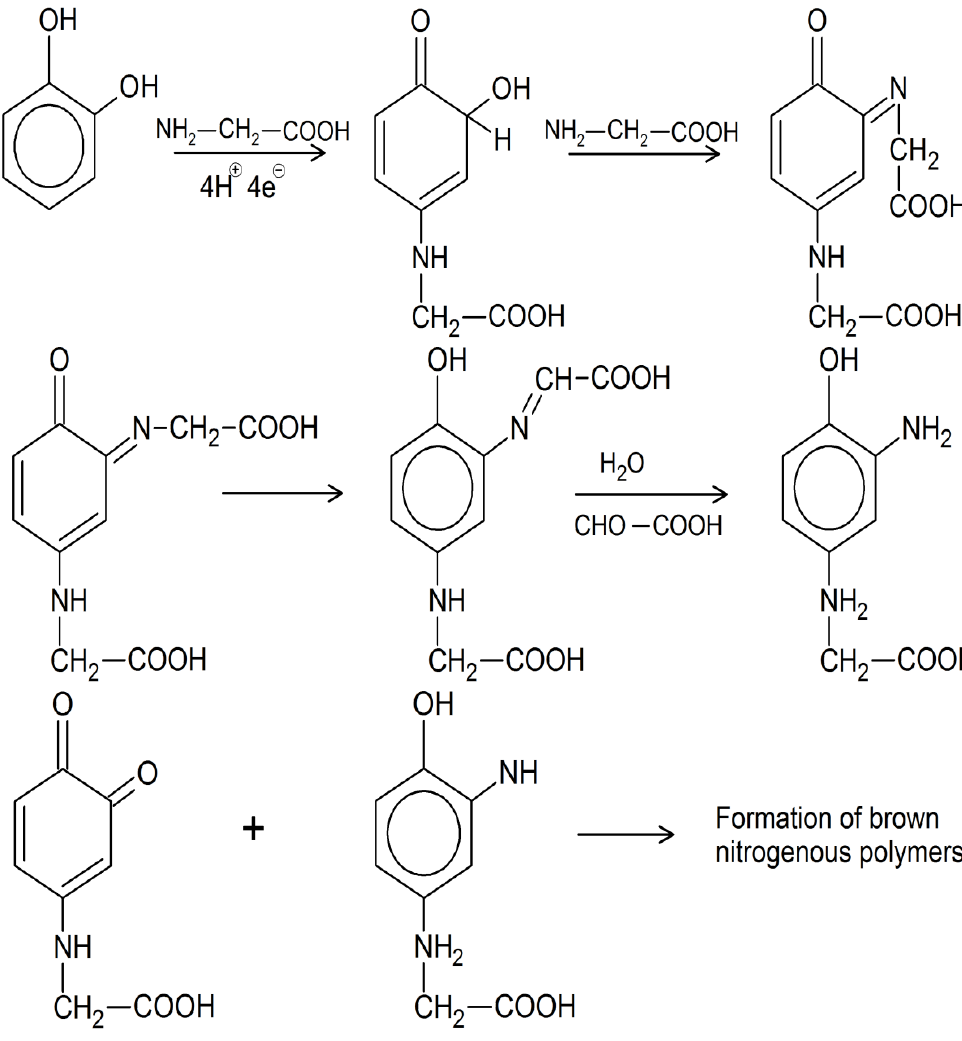
Figure 3. Formation of humic substances from catechol and glycine (after Stevenson [6], modified).